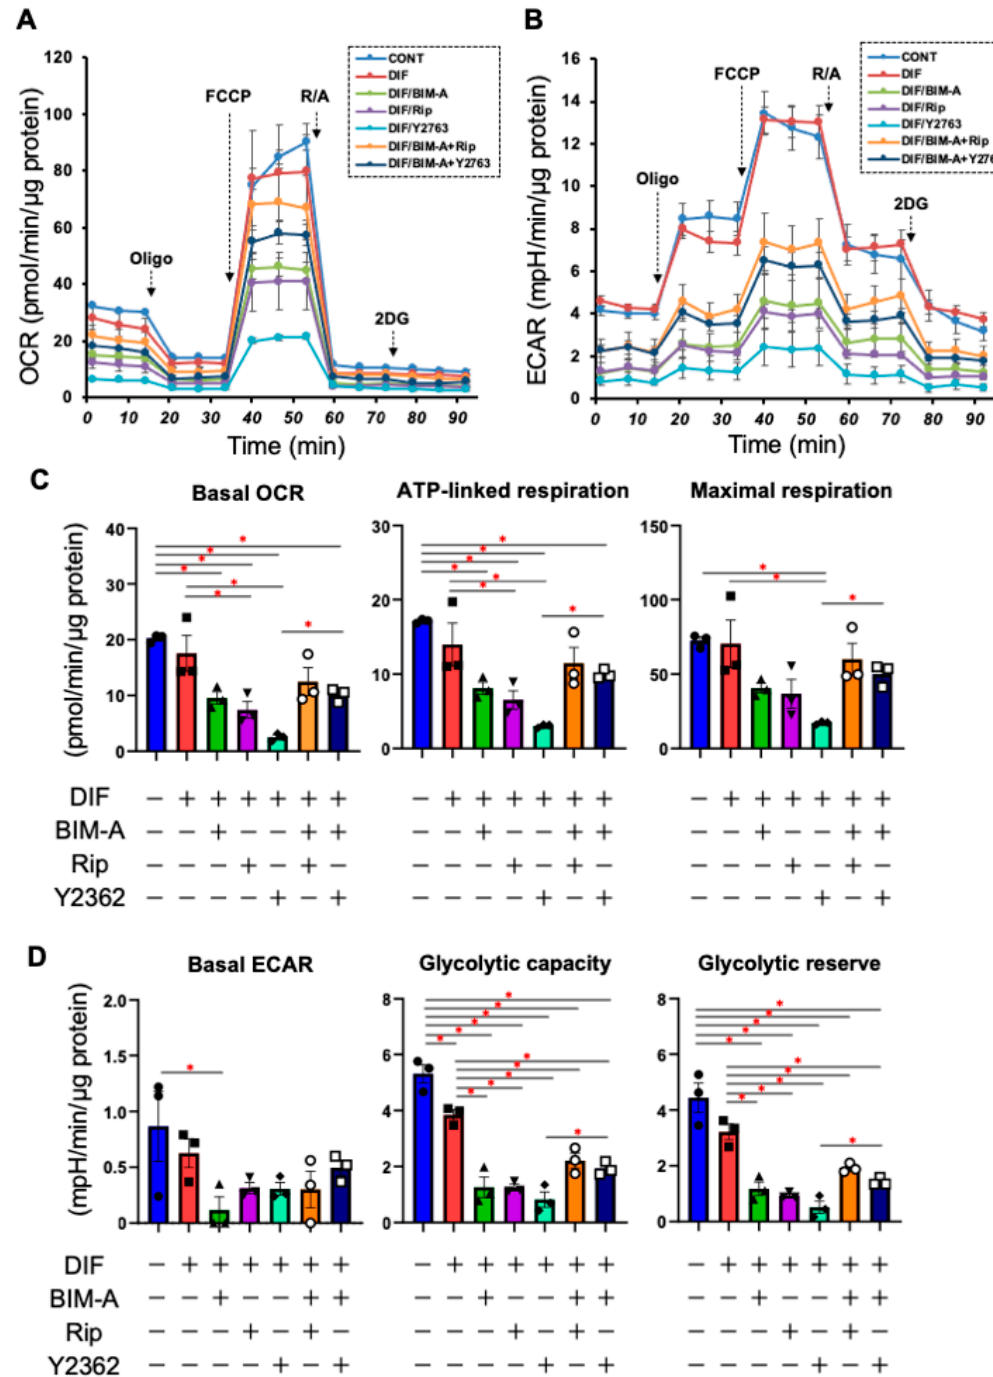
Figure 4. Additional effects of ROCK-i on BIM-A on the real-time cellular metabolic analysis of 2D planar cultured 3T3-L1 cells. The 3T3-L1 cells were 2D-cultured under several conditions: preadipocytes of 3T3-L1 cells (CONT) and their adipogenic differentiation (DIF) in the presence or absence of 100 nM BIM-A (BIM-A) and/or ROCK-i (10 μ M Ripasudil (Rip) or 10 μ M Y27632) were examined via real-time metabolic function analysis using a Seahorse XFe96 Bioanalyzer. The oxygen consumption rate (OCR, panel ( A )) and extracellular acidification rate (ECAR, panel ( B )) were measured, and thereafter, they were further measured after subsequent supplementation with oligomycin (a complex V inhibitor), FCCP (a protonophore), and rotenone/antimycin A (complex I/III inhibitors) and 2DG (a hexokinase inhibitor). The main parameters of the cellular metabolic analysis are shown in panels ( C ) and ( D ), respectively. Basal OCR was calculated by subtracting the OCR with rote- none/antimycin A from the OCR at baseline. ATP-linked respiration was analyzed by subtracting